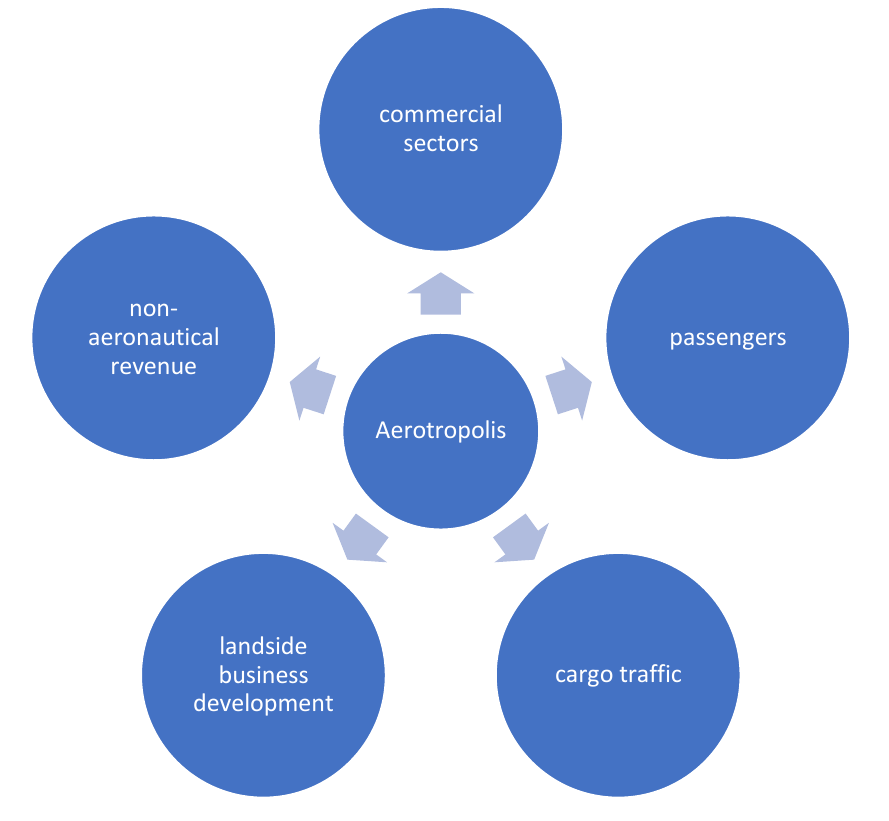
Figure 3. Pull factors.